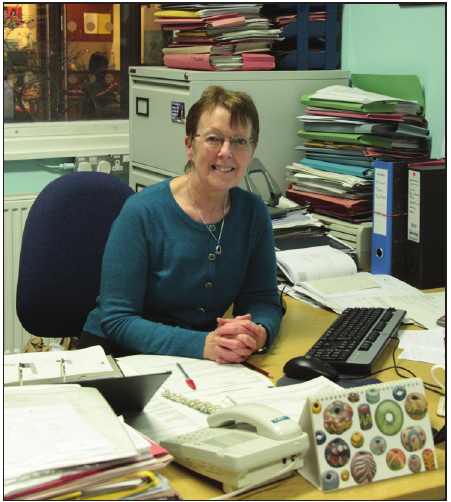
Figure 1: Barbara Brown (Photo Lisa